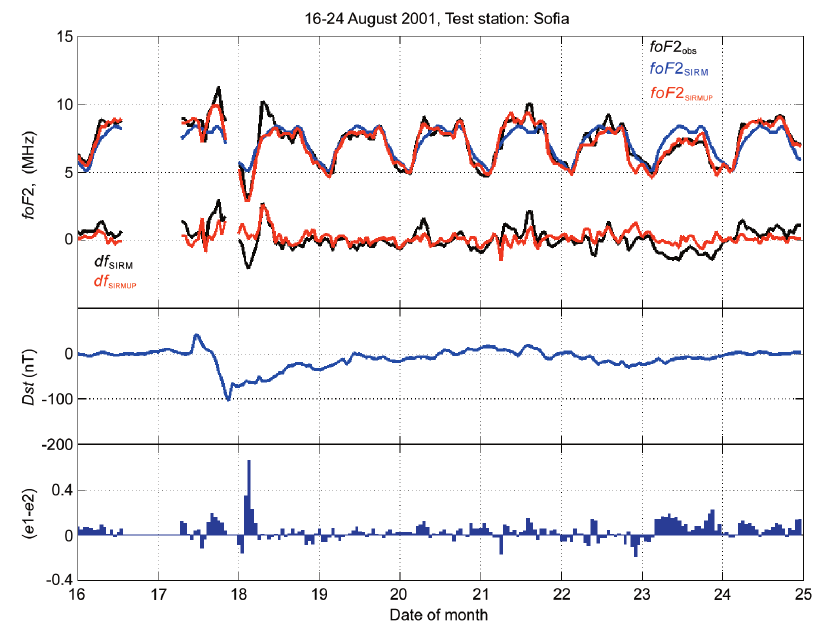
Fig. 3. Simulation results for the storm period 16-24 August 2001 at the test station in